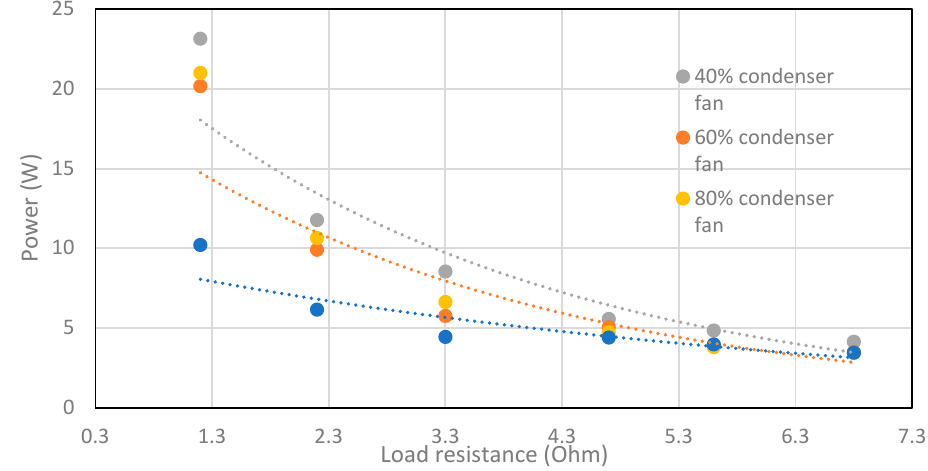
Figure 14. Variation of TEGs efficiency with load resistance at different values of condenser load. 6.4. Analysis of Refrigeration Cycle The previous results show that the integration of HE-TEGs affects the performance of refrigeration cycle. Analysis of the cycle on the p-h diagram before and after integra- tion of HE-TEGs unit is shown in Figure 15. This analysis would give an overall picture of the dynamic changes of the cycle introduced by using HE-TEGs unit. Please refer to Figure 1 for labelling of different points in the system. The cycle of basic system is rep- resented by dotted lines whereas the cycle with HE-TEGs unit is represented by solid lines. It can be observed that the integration of HE-TEGs unit results in a reduction of condenser and evaporator pressures, as shown in Table 2. Reduction in condensation pressure may be related to heat recovered by the HE-TEGs unit during the process from point 2 to 5 which results in more effective cooling of refrigerant in the condenser tubes. Heat transfer in the condenser is enhanced because of reduction of volume occupied by refrigerant gas at the entry of compressor and high heat transfer coefficient during the condensation process. As compared to the basic system, the compressor outlet tempera- ture decreases by about 10 °C and the pressure ratio of compression process decreases from 3.1 to 2.88. Therefore, compressor work, indicated by the difference in enthalpy change during the compression process from point 1 to 2 between compressor inlet and outlet, decreases with the integration of HE-TEGs unit. On the other hand, the refrigera- tion effect represented by the process from point 4 to point 1 between the evaporator inlet and outlet, increases in the presence of HE-TEGs unit. Consequently, these changes result